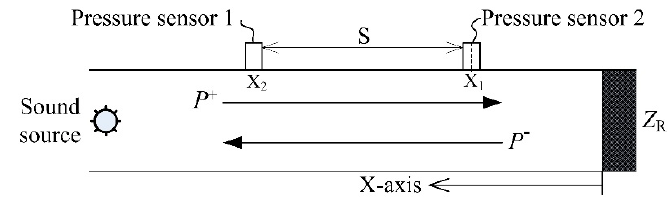
Figure 2. Schematic view of the acoustic